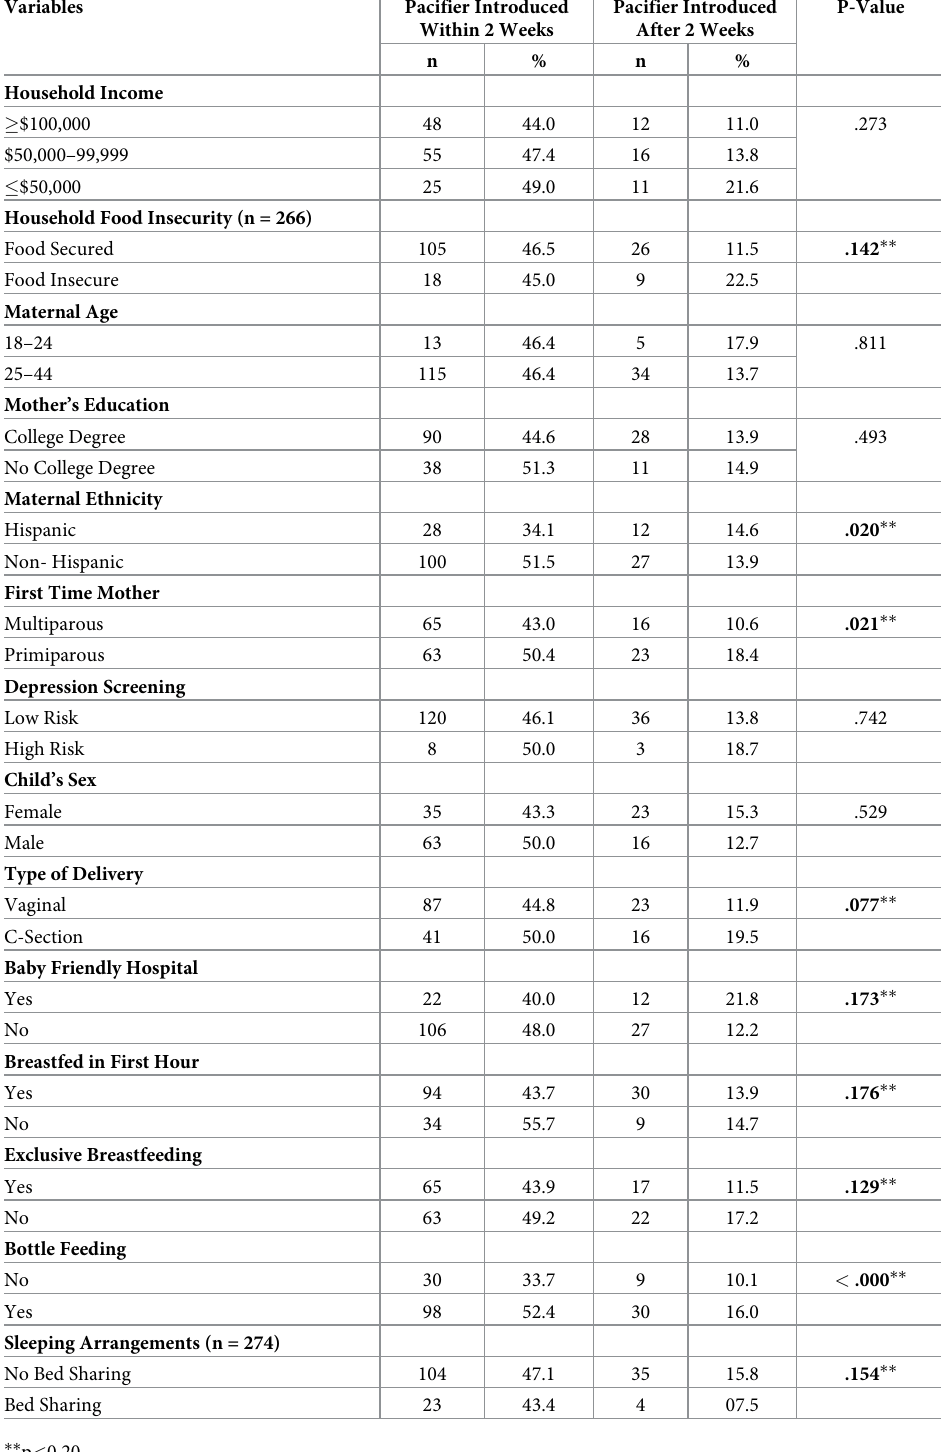
Table 3. Bivariate analysis of the age of pacifier use introduction by household, maternal, infant, and health care characteristics, and infant feeding and sleeping practices,